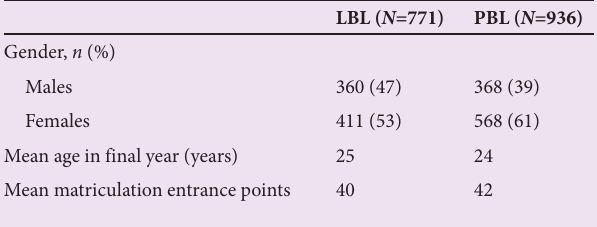
Table 1. Descriptive statistics for the two cohorts of students